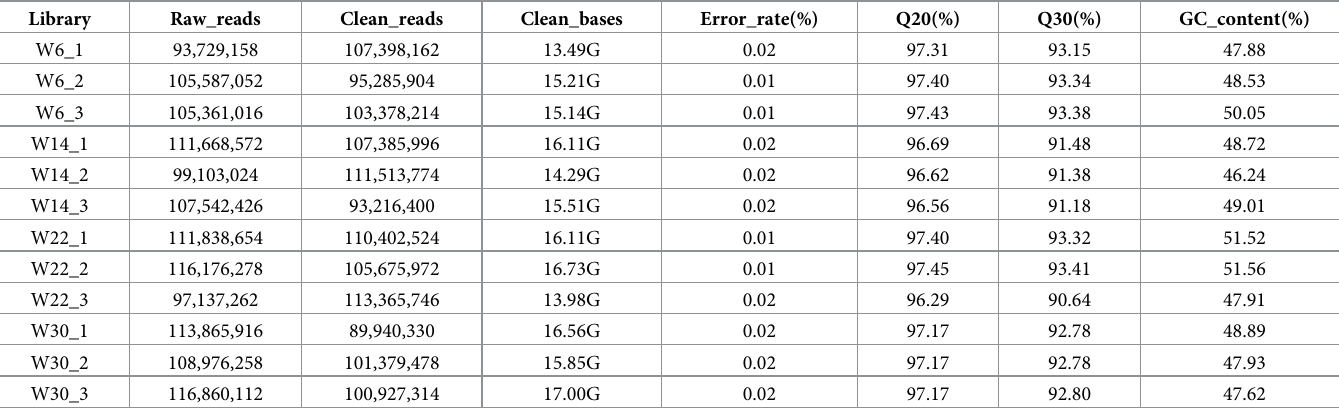
Table 1. Sequencing results and quality evaluation in 12 libraries.